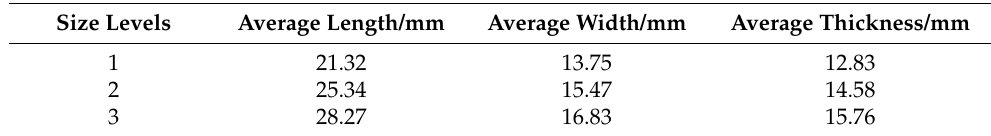
Table 1. Three-dimensional sizes of seeds.